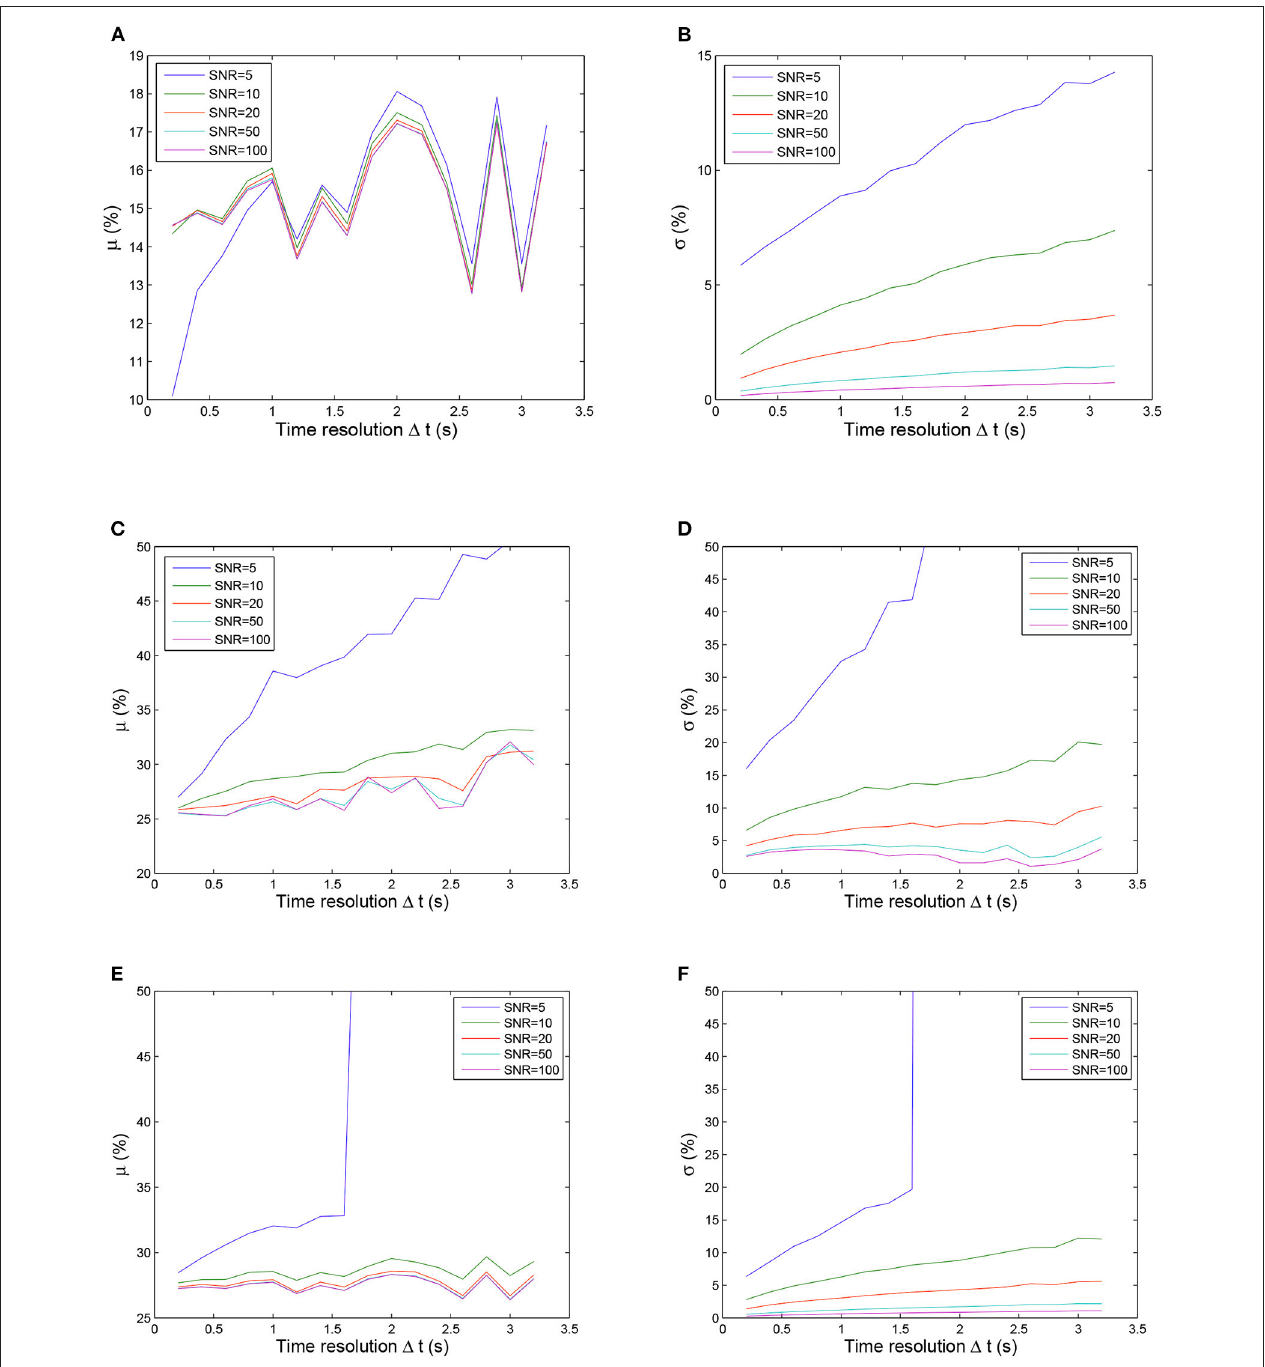
FIGURE 4 | Uncertainty µ (left column) and σ (right column) values calculated using three fitting methods as functions of the time resolution for five SNR values. Note that the ordinate scale is smaller for the proposed method than for other two methods for clarity. The fitting procedure was considered to have failed if the values of the µ and σ uncertainties were larger than 50 % of the correct values. From top to bottom: proposed method, LL-LS method, and nonlinear method. (A) Uncertainty µ values calculated using the proposed method. (B) Uncertainty σ values calculated using the proposed method. (C) Uncertainty µ values calculated using